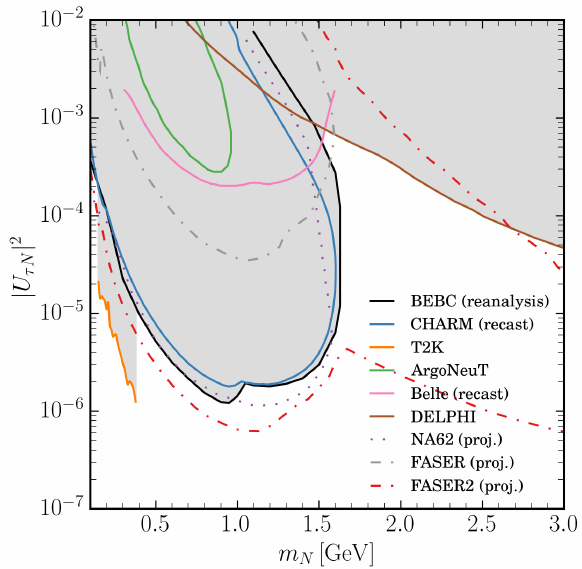
Figure 4: The 90% exclusion region in the HNL mass versus its mixing with ν τ set by reanalysis of BEBC WA66, compared to the recast [ 13 ] of the CHARM bound. Also shown are bounds from T2K [ 6 ] , ArgoNeuT [ 7 ] , a recast of Belle [ 8 ] , and DELPHI [ 15 ] , as well as the projected sensitivities of NA62 in beam dump mode [ 55 ] and FASER / FASER2 [ 57 ] .